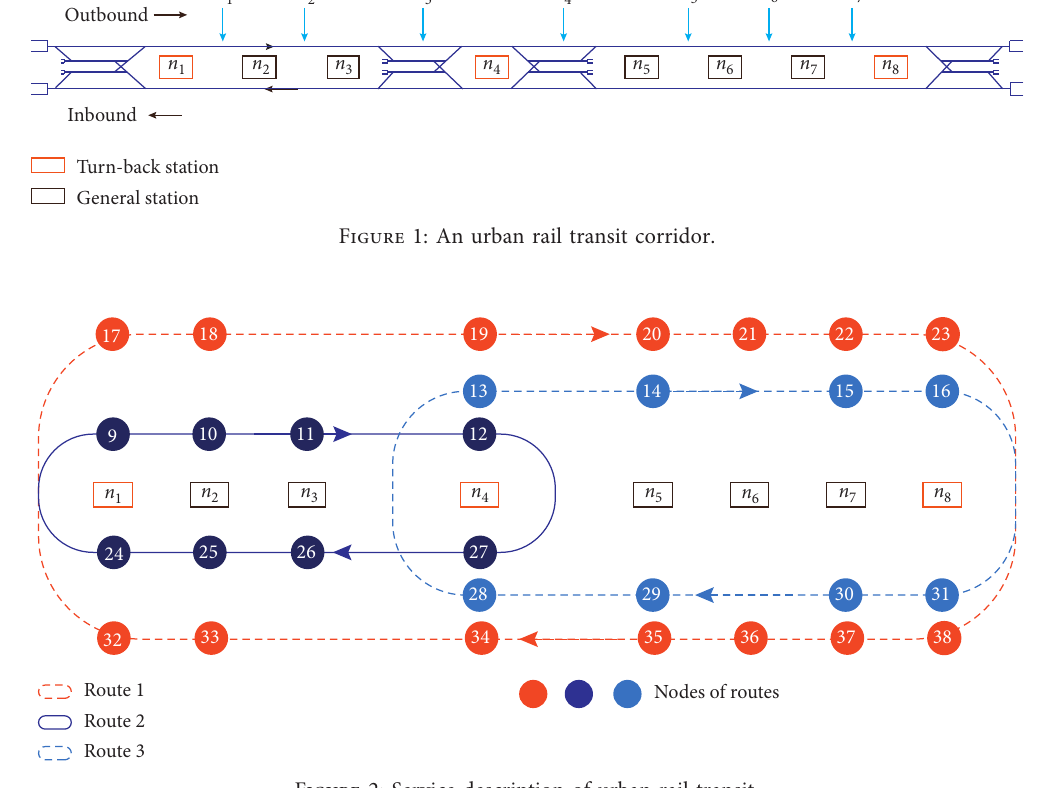
Figure 2: Service description of urban rail transit.